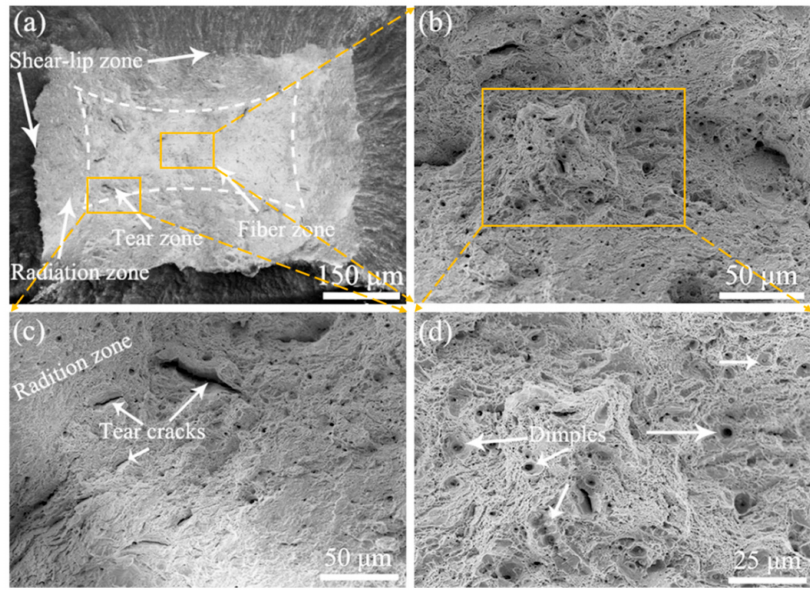
Figure 9. Fracture morphology of 9Cr-F/M steel at RT: ( a ) macro view presenting rectangular necking, ( b ) magnified image of the fiber zone, ( c ) magnified view of the radiation zone, and ( d ) magnified image from the middle of ( b ).